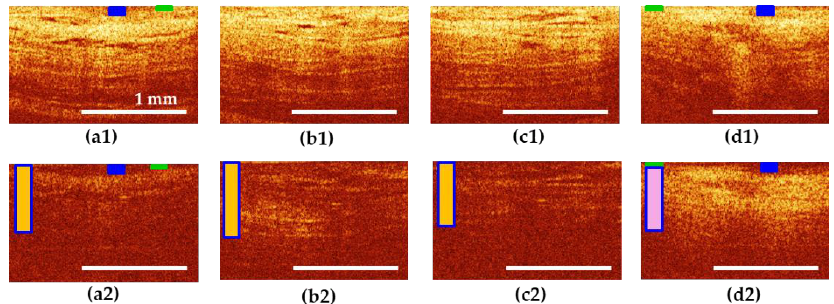
Figure 6. CP OCT images of the bladder neck ( a ) and three segments of the urethra ( b – d ) in patient E., 60 years old with UPS lasting 5 years. ( b ) proximal; ( c ) middle; and ( d ) distal parts of the urethra. The first row shows co-polarization images, the second row shows corresponding cross-polarization images. ( a , d ) Epithelium has signs of norm (blue rectangle), but mostly atrophic (green rectangle); ( b , c ) total epithelial atrophy is observed. ( a – c ) Connective tissue have normal thickness (dark blue frame of vertical rectangle), but signs of active inflammation (yellow color of vertical rectangle); ( d ) connective tissue has normal thickness (dark blue frame of vertical rectangle), but signs of fibrosis (pink color of vertical rectangle).